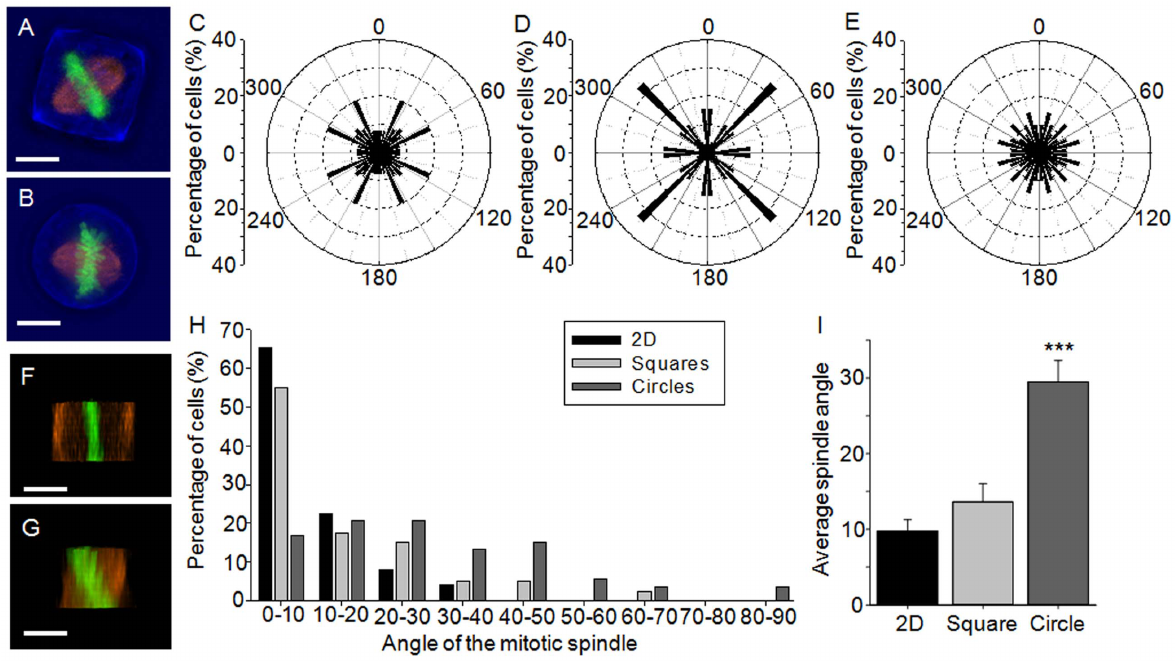
Figure 2. Effect of cell shape on the orientation of the mitotic spindle. The angle of mitotic spindle at metaphase was assessed in HeLa (GFP- H2B/RFP-tubulin or GFP-centrin-2/RFP-tubulin) cells cultured on the different platforms. To determine the orientation of the spindle parallel to the substrate plane, cells were imaged for microwell and cell shape (transmission channel, blue), DNA (green) and tubulin (red) after culture in (A) square microwells or (B) circular microwells; bars: 10 m m. Cells cultured (C) on 2D substrates or (E) within circular microwells possessed a random orientation of the mitotic spindle. (D) Conversely, a high proportion of the cells cultured in square microwells aligned the spindle along the long axis of the cell. To determine the orientation of the spindle perpendicular to the substrate plane, z stacks were reconstructed to obtain the xz view of the cell. Representative images are shown of cells with a (F) parallel versus (G) tilted orientation of the mitotic spindle; bars: 10 m m. (H) The angle of the spindle was dependent on whether cells were cultured on 2D homogenously coated substrates (black bars), or within square (light grey bars) or circular (dark grey bars) microwells. A higher percentage of cells cultured in circular microwells exhibited tilting of the mitotic spindle, in comparison to cells cultured in square microwells and on 2D substrates. (I) Furthermore, on average greater tilting was observed after cells were cultured in the circular microwells, while the mitotic spindle was aligned nearly parallel to the substrate in cells cultured in 2D or square microwells. Values represent spindle angle in degrees 6 SEM. Key: *** p ,